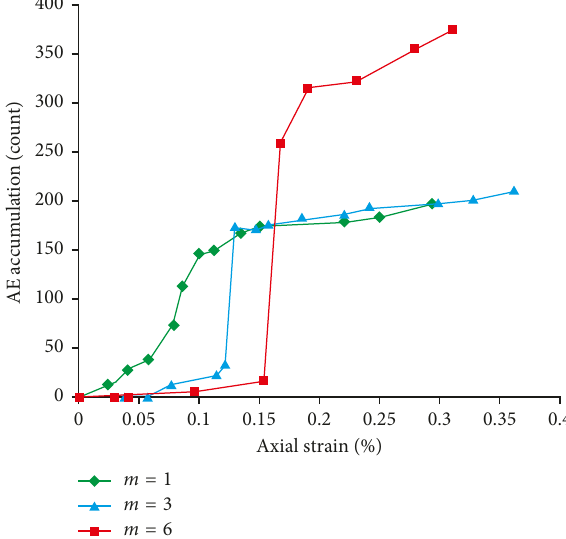
Figure 16: The release of strain energy versus axial loading for the numerical specimens with different homogeneity indices.